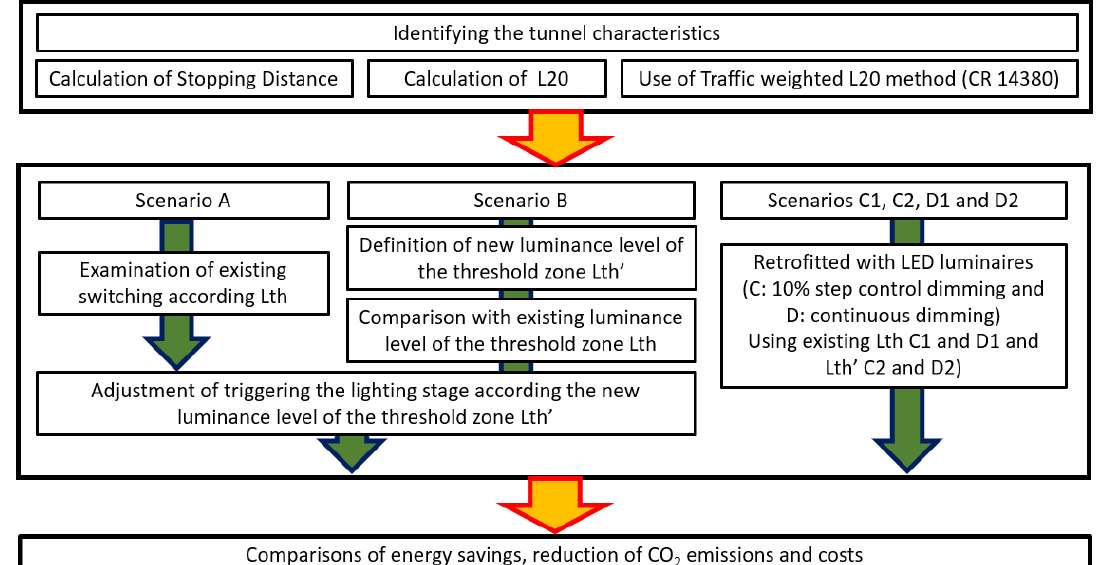
Figure 1. Diagram of the proposed methodology with the examined scenarios. Lighting Emitting Diodes (LED); threshold luminance (Lth); new corresponding threshold zone luminance